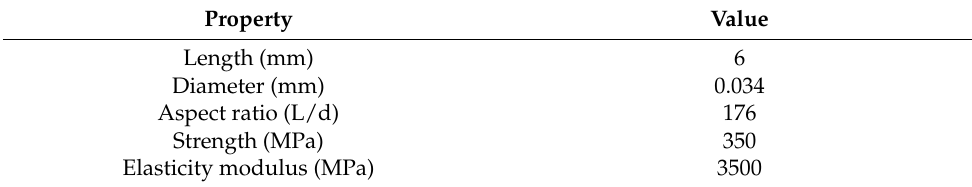
Table 4. Characteristics of PP fibers